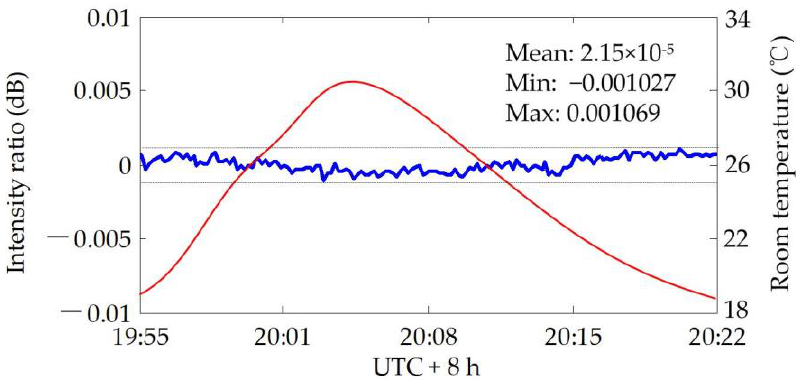
Figure 8. The results of the normalized intensity ratio after system calibration.